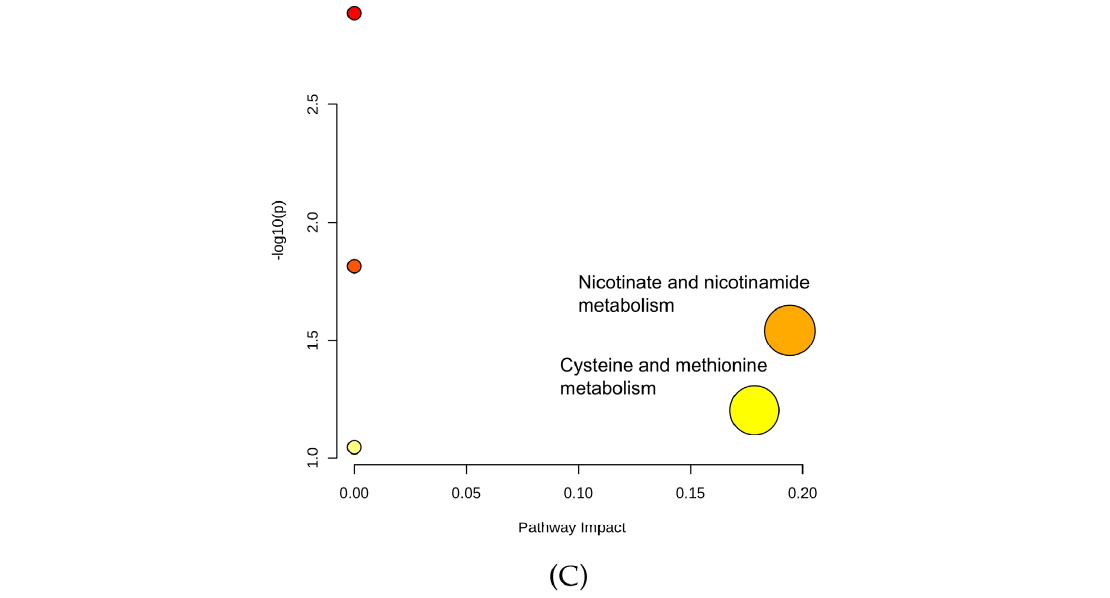
Figure 8. ( A ) OPLS-DA two-class model and ( B ) PCA plot of LC-MS data from patients with (blue circles) and without 1p19q codeletion (green squares). ( C ) Pathway analysis of metabolites present in patients due to1p19q codeletion.